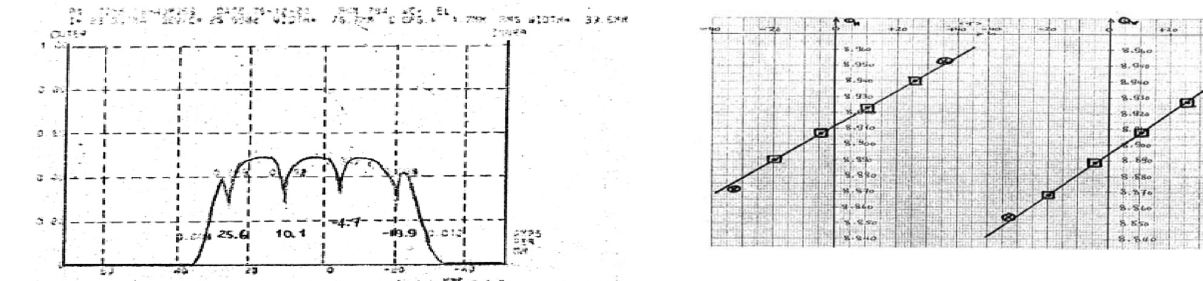
FIG. 12. Longitudinal Schottky with markers inserted by phase displacement.